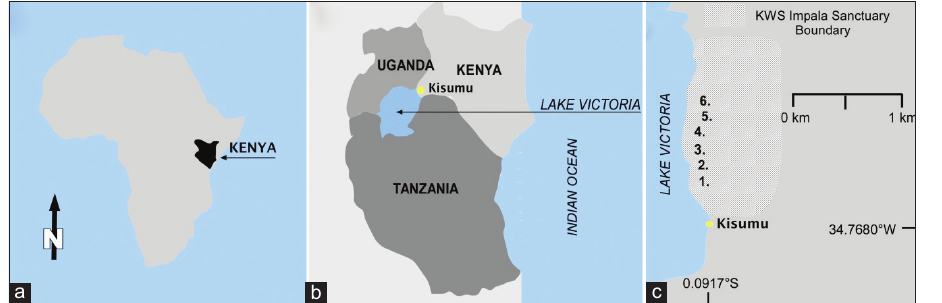
cba Figure-1: (a) Location map of Kenya in Africa. (b) Location map of Kenya in relationship to Lake Victoria. (c) Site map of the sample sites within the Kenyan Wildlife Service Impala Sanctuary, Kisumu, Kenya.